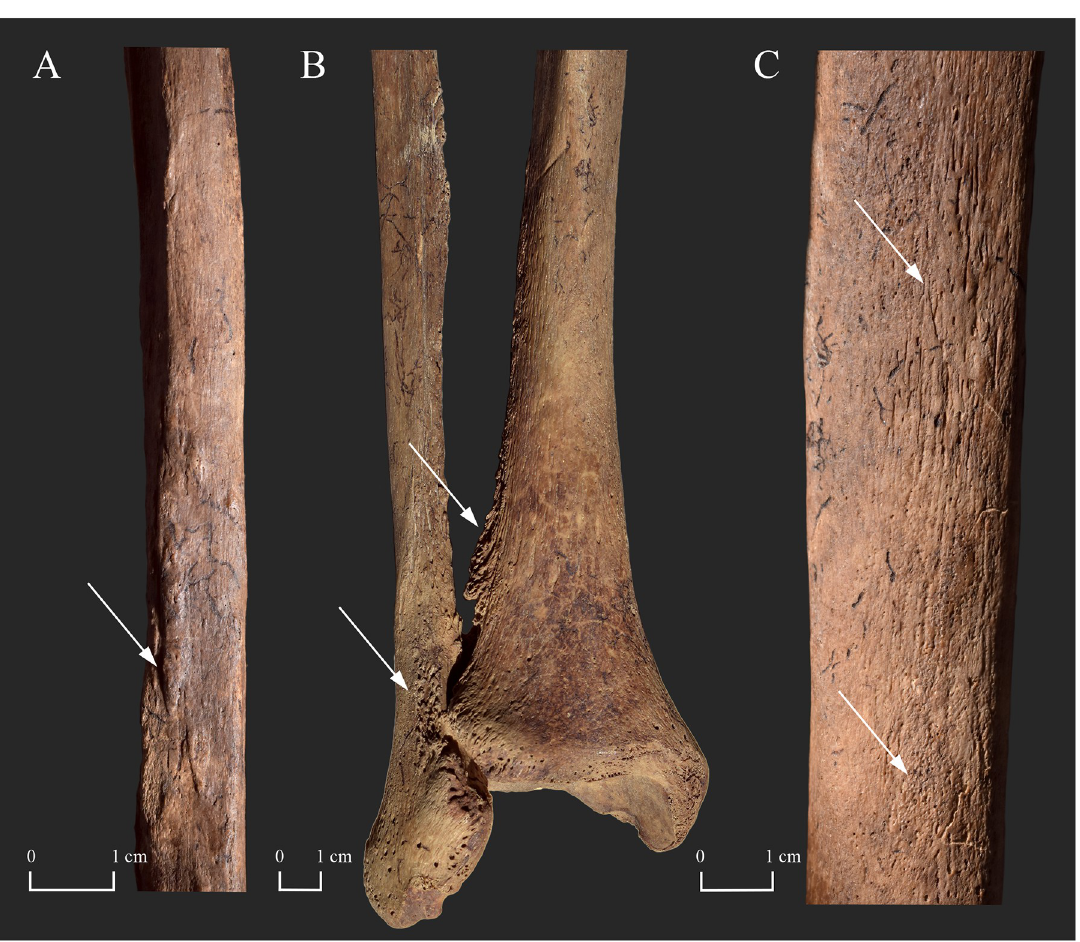
Fig 7. A) Subperiosteal new bone formations on the shaft of the right fibula (posterior surface–white arrow) of KD271; B) Exostoses on the distal part of the right fibula and tibia (adjacent surfaces–white arrows) of KD271; and C) Surface pitting and longitudinally striated subperiosteal new bone formations on the shaft of the right tibia (medial surface–white arrows) of KD271.